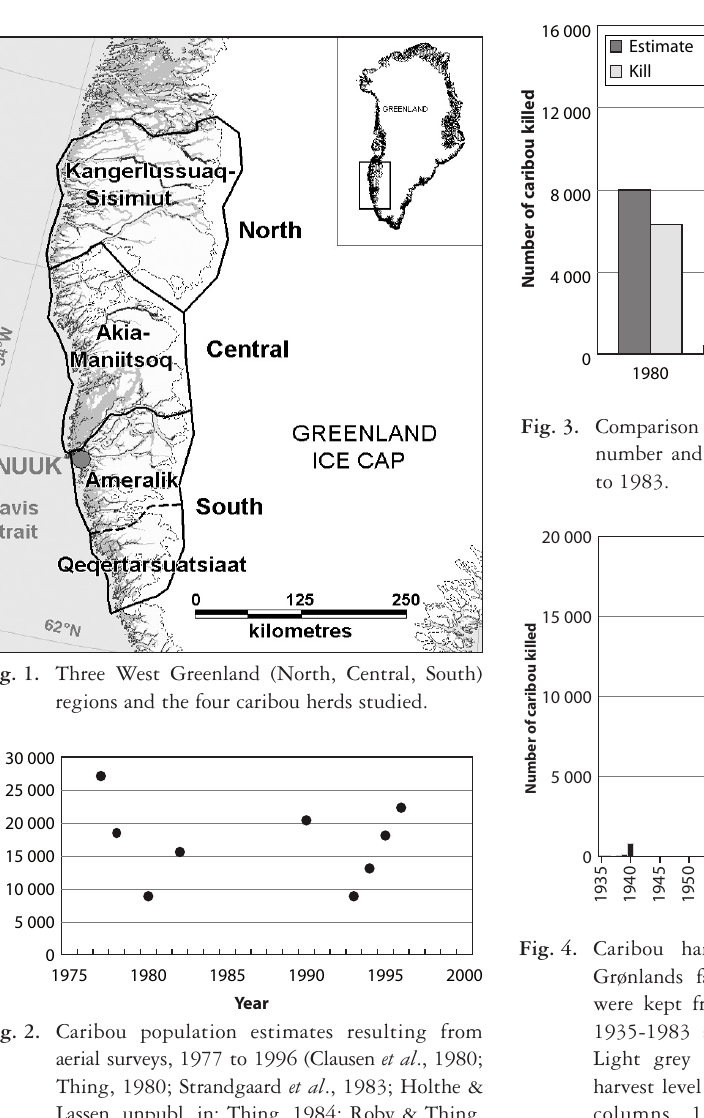
Fig. 2. Caribou population estimates resulting from aerial surveys, 1977 to 1996 (Clausen et al ., 1980; Thing, 1980; Strandgaard et al ., 1983; Holthe & Lassen, unpubl. in: Thing, 1984; Roby & Thing, 1985; Thing & Falk 1990; Rasmussen, 1995; Ydemann & Pedersen, 1999). All estimates lack confidence intervals, and prior to 1993 systematic method was absent.